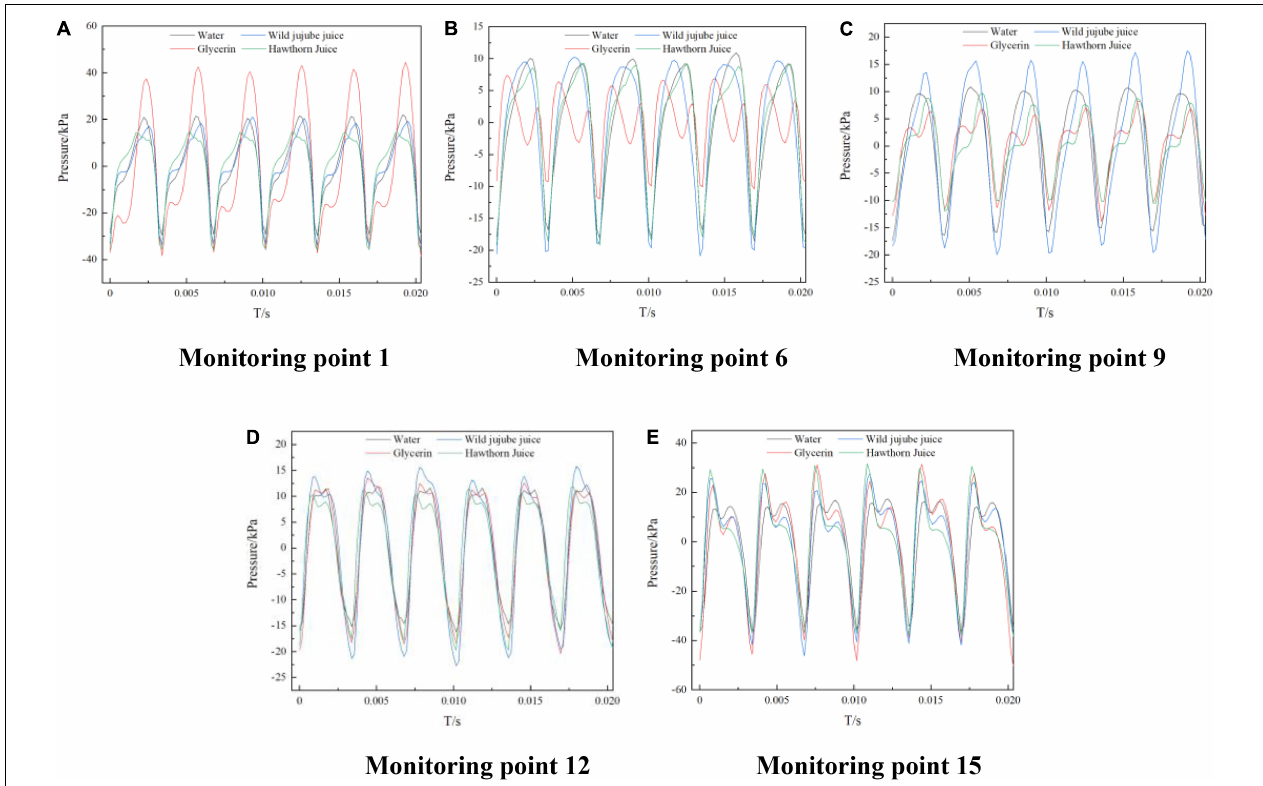
FIGURE 10 | Time-domain distribution of pressure pulsation on volute casing of the centrifugal pump with different viscosities. (A) Monitoring Point 1, (B) Monitoring Point 6, (C) Monitoring Point 9, (D) Monitoring Point 12 and (E) Monitoring Point 15.